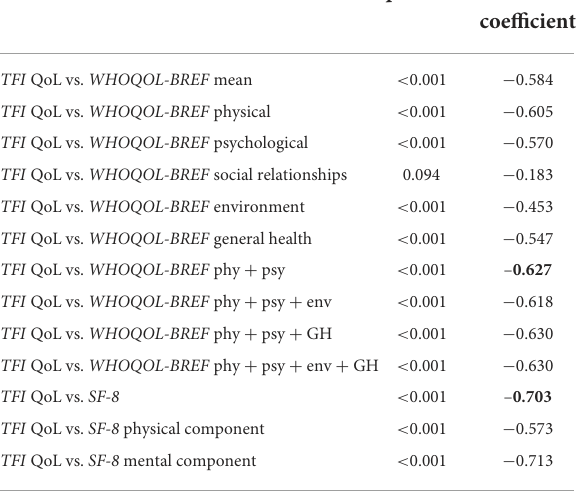
TABLE 4 Correlations between QoL subdomain of TFI and all subdomains of HRQoL questionnaires ( WHOQOL-BREF and SF-8 ). p -value